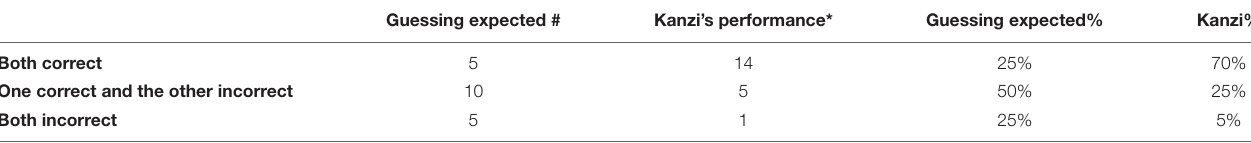
TABLE 3 | Comparison of random guessing expected performance vs. Kanzi’s actual performance for pairs of